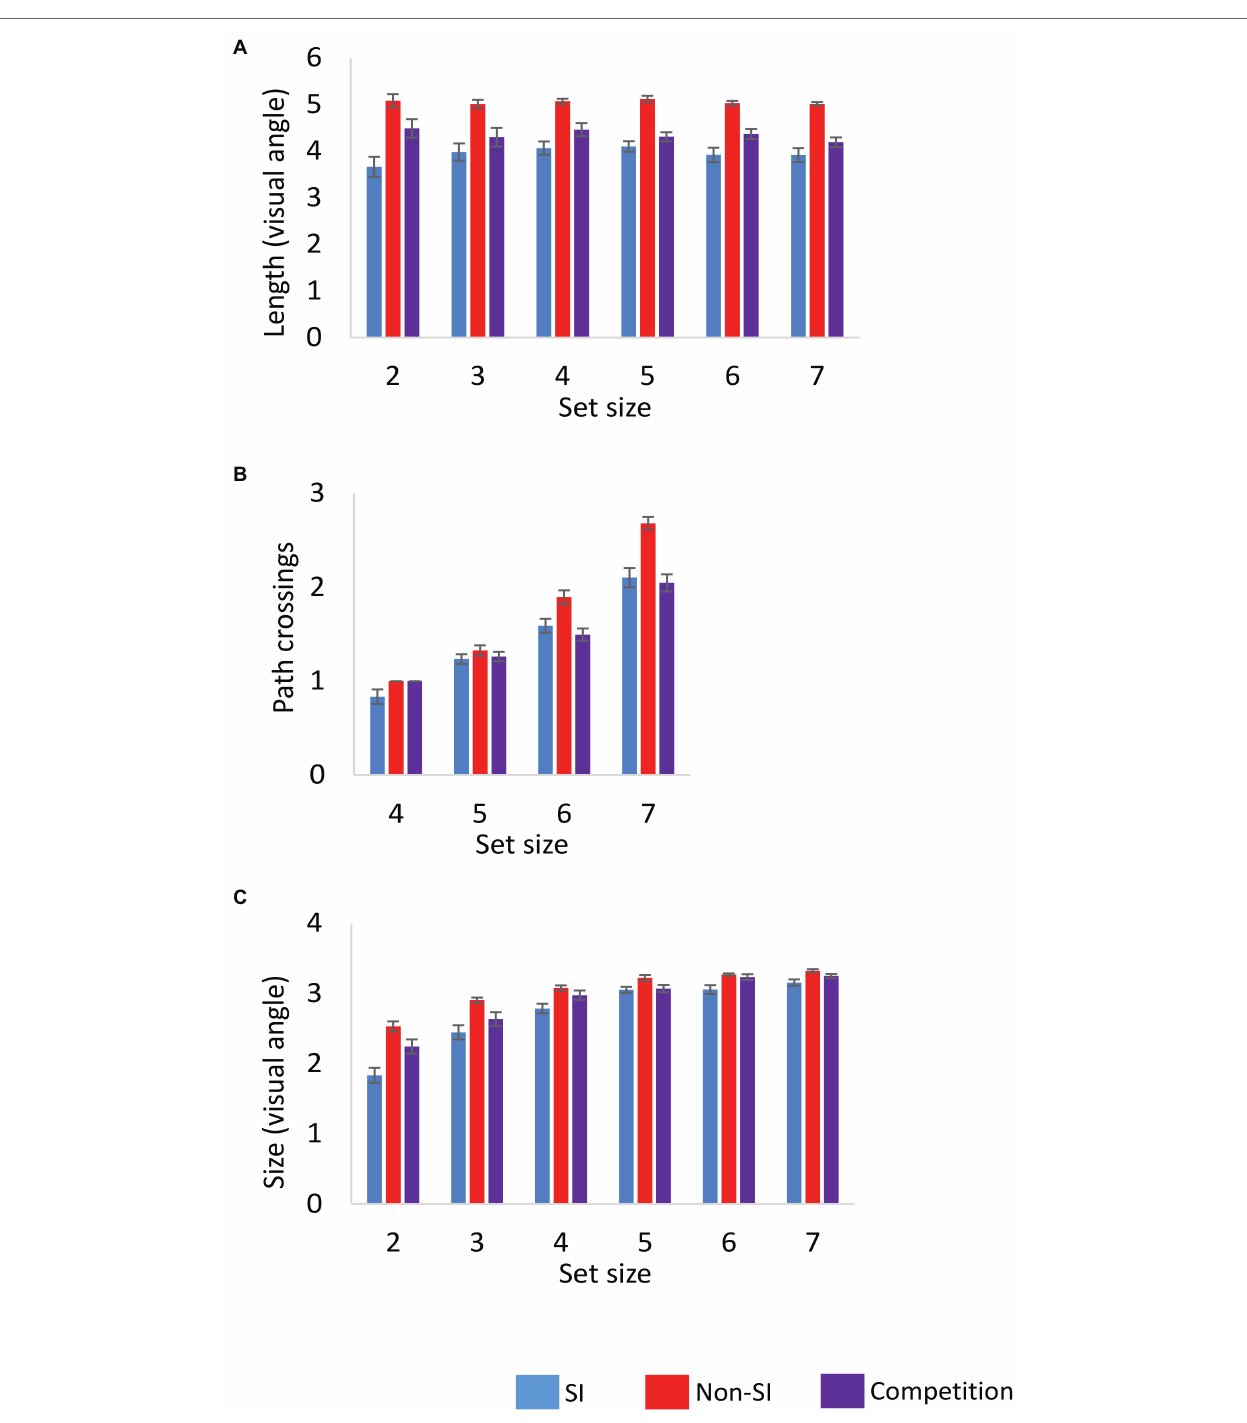
in the horizontal and vertical axes. The movements were also analyzed in the non-SI condition for comparison. Each movement was scored on both the horizontal and the vertical axes. On the horizontal axis, movements were divided into left, right,